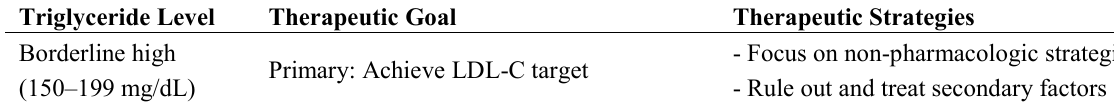
Table 5. Therapeutic goals and treatment strategies in